Question: Condense the content of this figure into a single sentence.
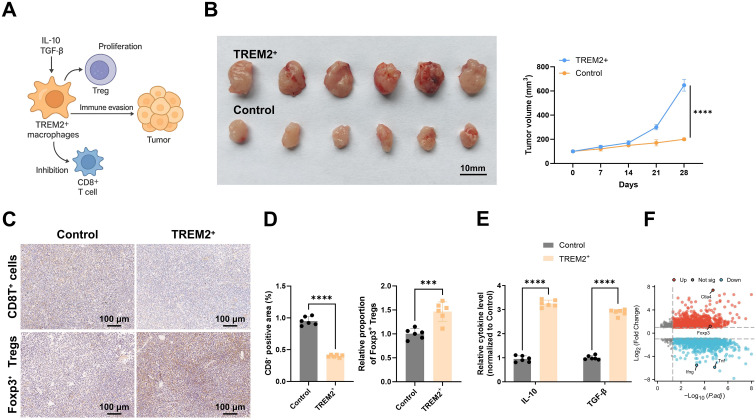
Answer: Pro-tumor function of TREM2 + macrophages and their immunoregulatory mechanism. (A) Schematic illustration of the mechanism by which TREM2 + macrophages facilitate immune evasion by secreting IL-10 and TGF-β to promote Treg proliferation, inhibit CD8 + T cell infiltration and effector function, thereby driving tumor immune escape; (B) Tumor size and growth curves in xenograft models comparing the TREM2 + macrophage-treated group and control group (n = 6); (C) Immunohistochemical staining of tumor tissues to evaluate the distribution and proportion of CD8 + T cells and Foxp3+ Tregs; brown staining indicates positive cells, bar = 100 μm; (D) Quantification of CD8 + T cell-positive area and Foxp3+ Treg cell proportion in tumor tissues by IHC; (E) ELISA analysis of the relative concentrations of the immunosuppressive cytokines IL-10 and TGF-β in tumor tissues; (F) Volcano plot illustrating differential expression of genes related to immunosuppression and effector T cell function. Each animal group included six mice. ns, p > 0.05; *** p < 0.001; **** p < 0.0001.